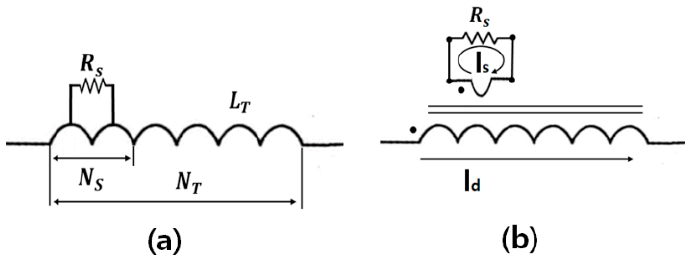
Figure 5. ( a ) Definition of inductance and number of turns by turn short circuit and ( b ) two inductances due to turn short circuit.